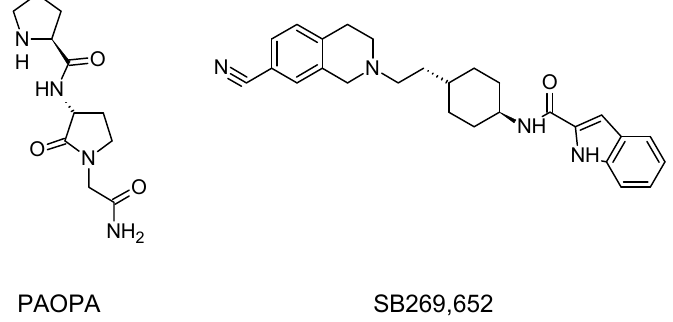
Figure 3. Allosteric modulators of dopamine D 2 receptor with possible application for the treatment of schizophrenia.